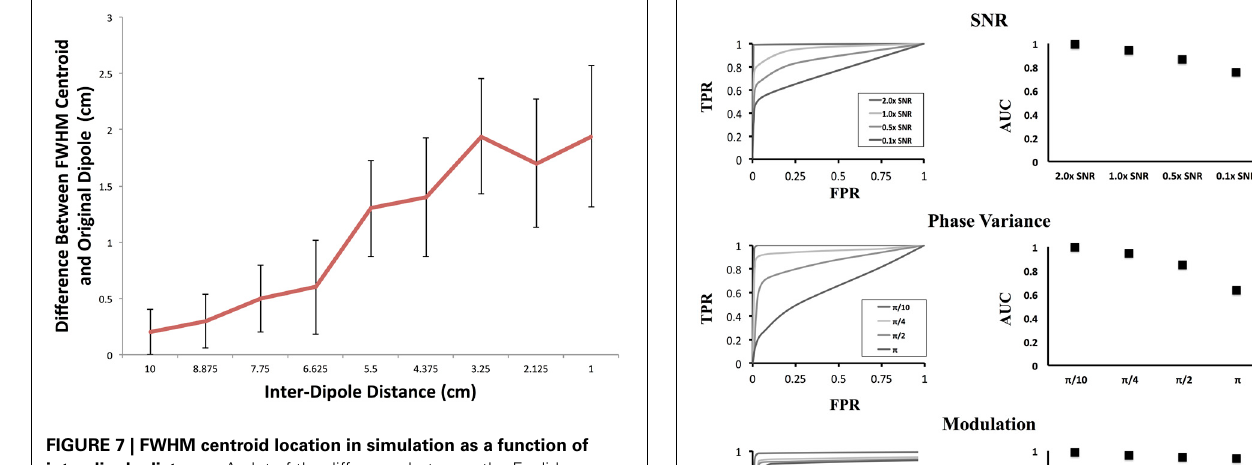
FIGURE 7 | FWHM centroid location in simulation as a function of inter-dipole distance. A plot of the difference between the Euclidean distance between the FWHM centroid location and the originally simulated dipole. As the distance between the dipoles decreases, the FWHM clusters tend to be located non-uniformly around the original dipole location.